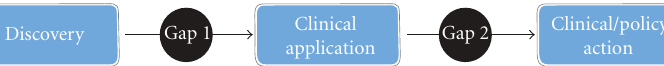
Figure 2: Two translation gaps in healthcare